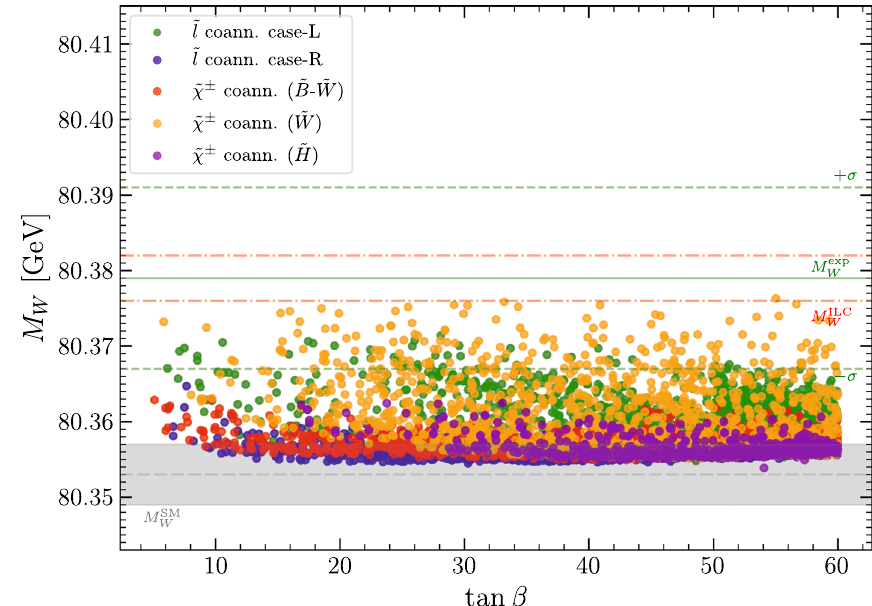
Fig. 7 Results for the five scenarios in the tan β – M W plane. The horizontal lines and the color coding are as in Fig.